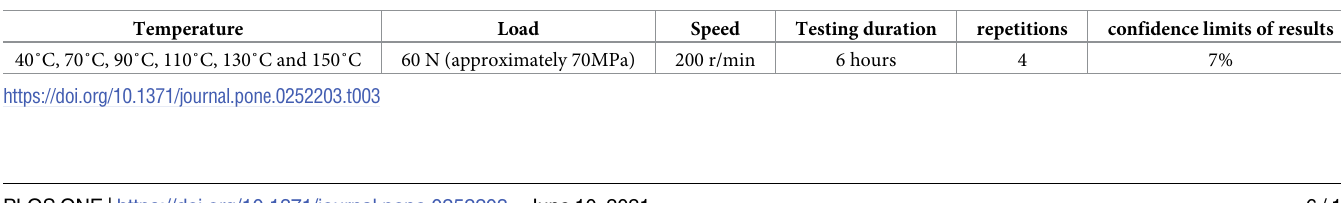
Table 3. The friction test